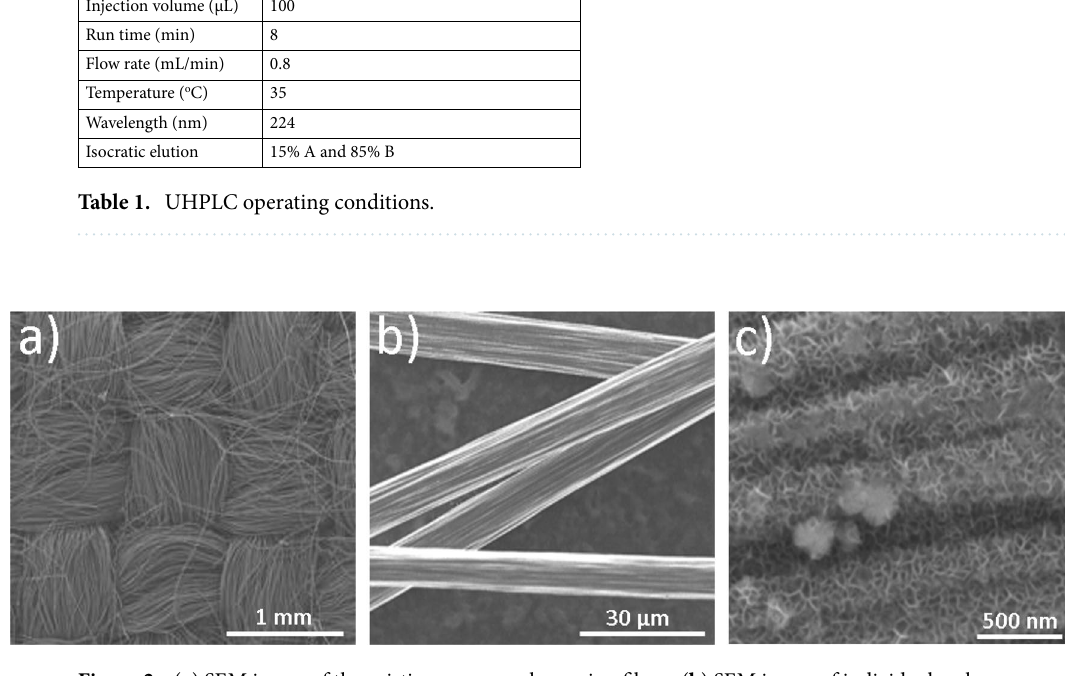
Figure 2. ( a ) SEM image of the pristine woven carbon microfibers, ( b ) SEM image of individual carbon microfibers. ( c ) SEM image of the final product (new catalyst with MnO 2 nanosheets grown on carbon